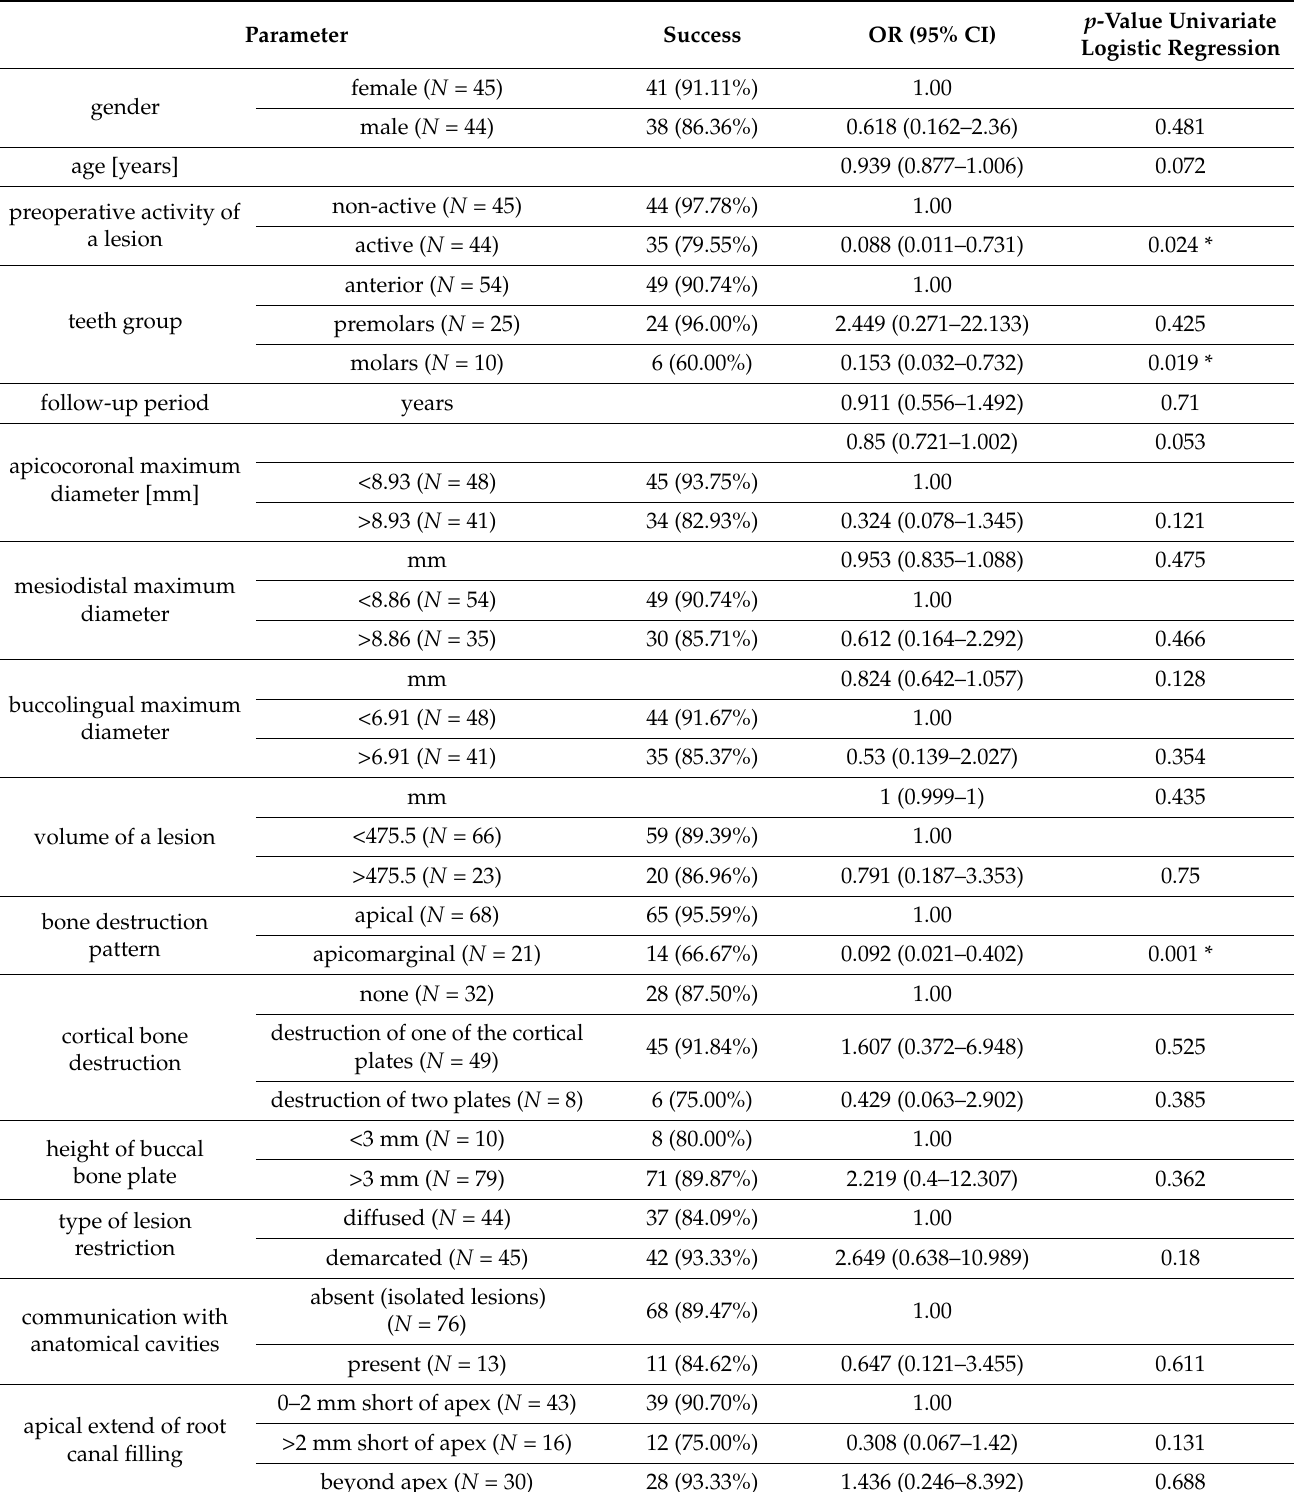
Table 3. Distribution of cases per preoperative demographic and clinical data as well as radiographic factors with the success rate; univariate logistic regression